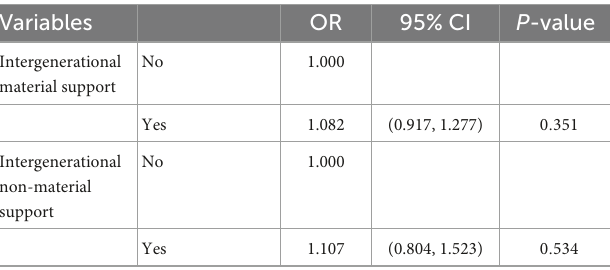
TABLE 3 The rank of importance of the factors influencing anxiety among the elderly.